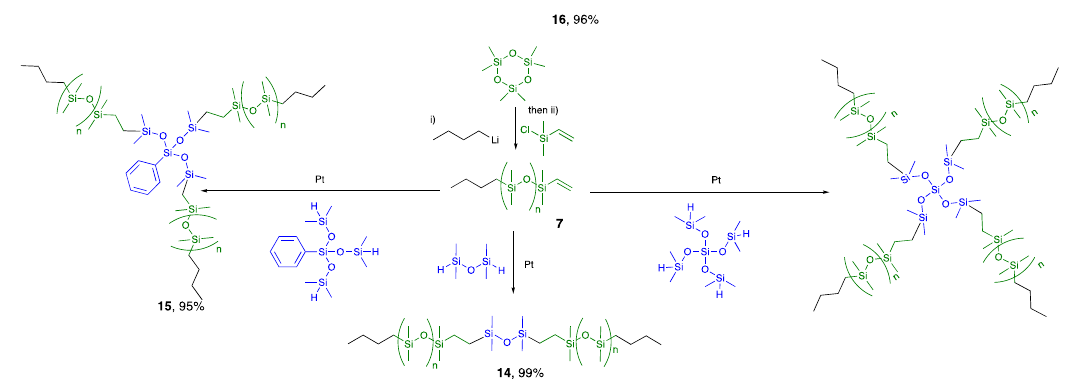
Figure 3. Synthesis of branched silicones starting from linear materials.